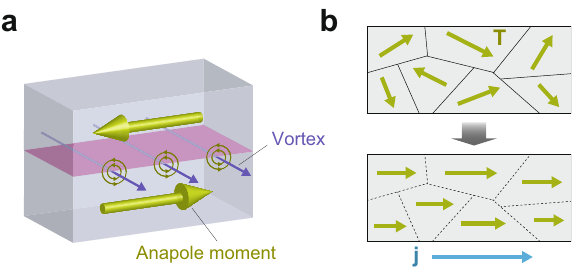
Fig. 4 Anapole domain and domain switching through supercurrent. a Vortices at the boundary of anapole superconducting domains. b The proposed domain switching in anapole superconductors. The effective anapole moment T is aligned along the injected supercurrent